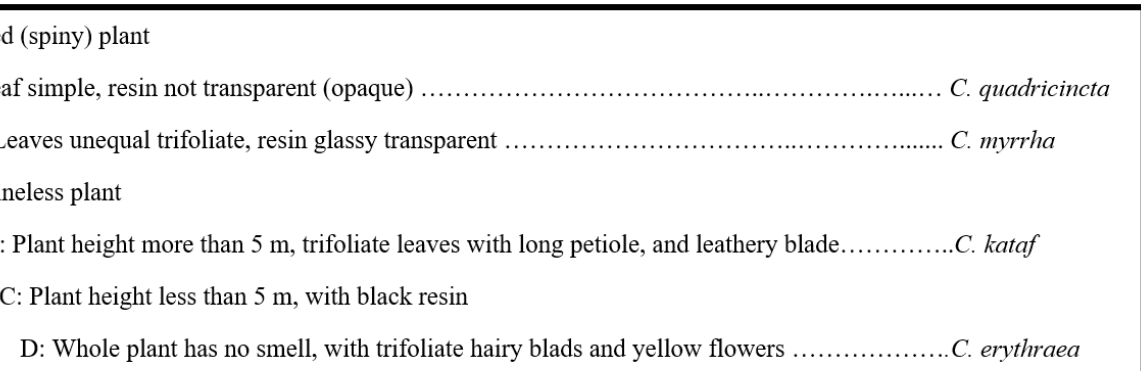
Figure 7. UPGMA dendrogam shows the relationships between the Commiphora species using the gross morphological characters.